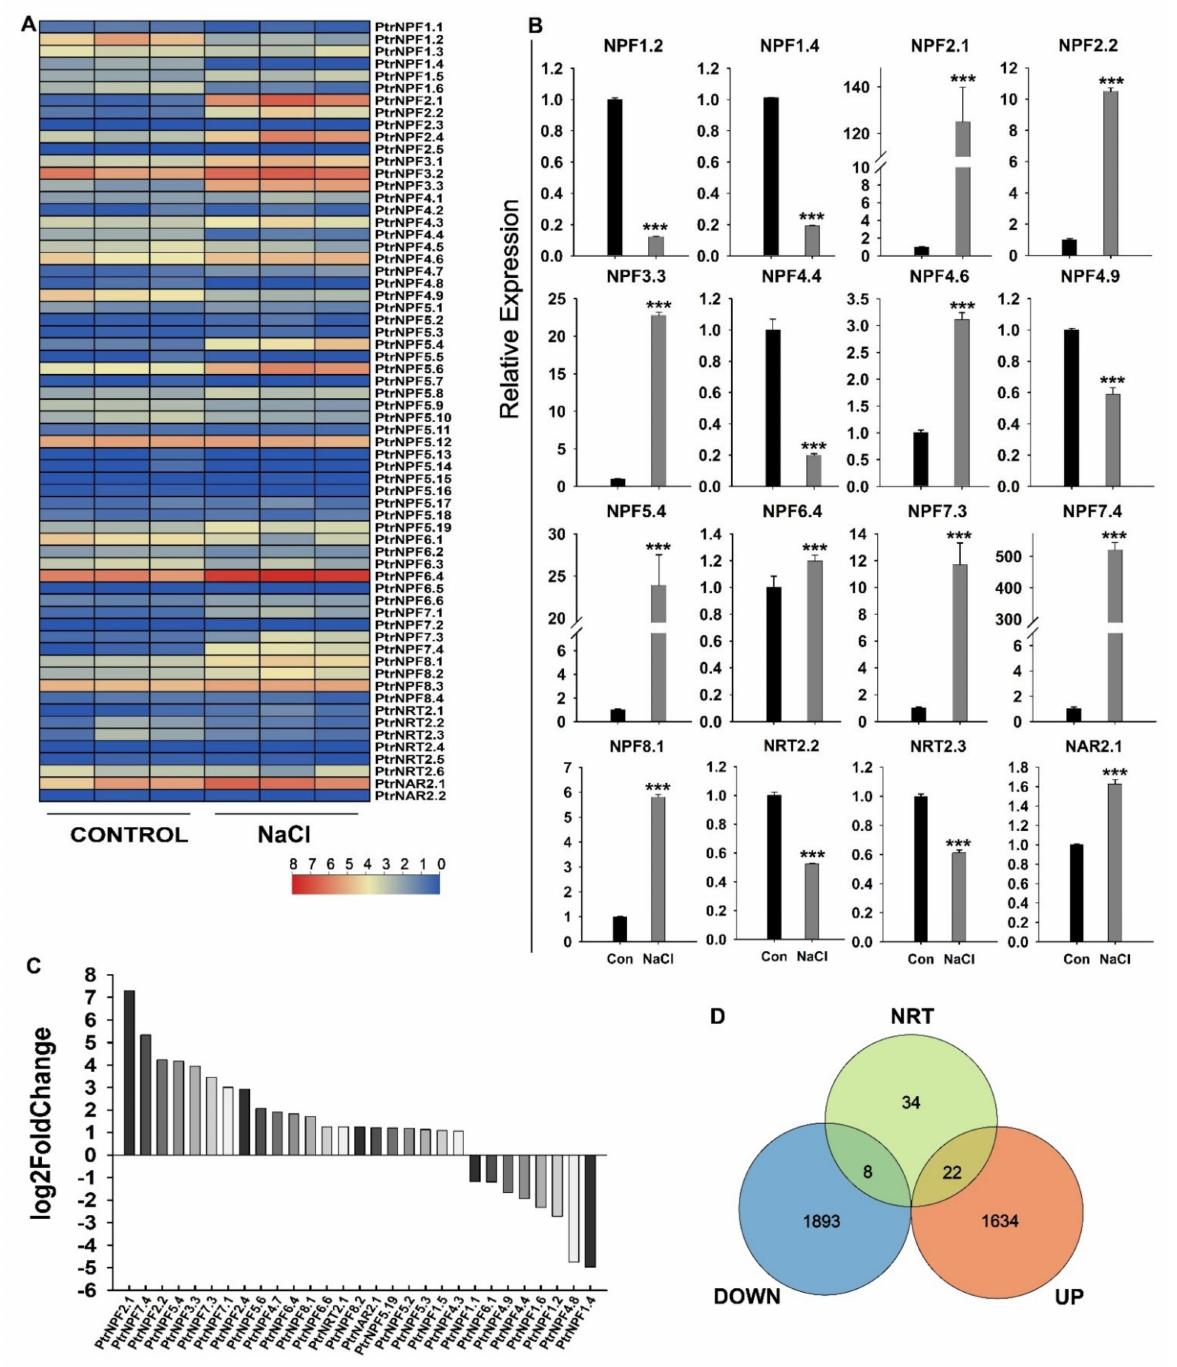
Figure 6. Differential gene expression of PtrNRTs under salt conditions. ( A ) The FPKM value from the control and NaCl treatment group. Each group had three biological repetitions. Heat map data was selected from RNA-seq (Tables S3 and S4). ( B ) The selected genes’ expression by qRT-PCR assay. The relative expression was calculated by 2 − ∆∆ CT method. *** Represented significant difference in comparison with control group using Student’s t -test at p < 0.001. ( C ) The representative differential expression genes under salt stress. ( D ) The Venn plot includes the up and down-regulated genes. The green circle represented all the 64 NRT genes. The red circle and the blue circle respectively represented the genes that up and down-regulated under salt stress (log2 Fold Change absolute value >